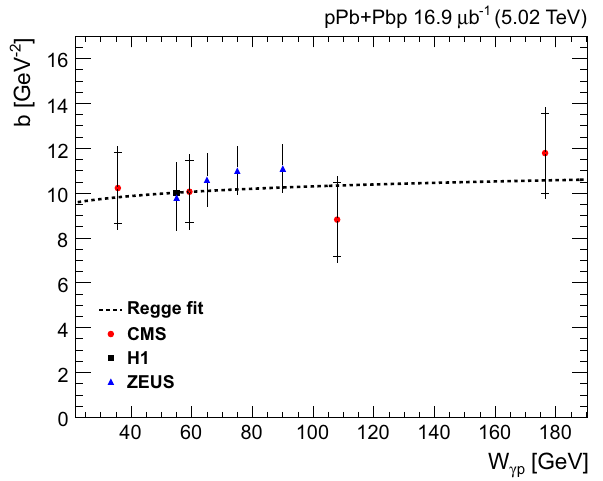
Fig. 6 Differential cross section d σ/ d | t | (full circles) for exclusive ρ ( 770 ) 0 photoproduction in the rapidity interval − 1 . 2 < y 0. The square symbols indicate the H1 results, and the triangles the ZEUS results. The error bars show the statistical uncertainty, while the shaded areas represent the statistical and systematic uncertainties added inquadrature.FortheH1data[18],theerrorbarsrepresentthestatistical andsystematicuncertaintiesaddedinquadrature,andfortheZEUSdata [17] the reported uncertainties are negligible Table 3 Differential cross section for exclusive ρ ( 770 ) 0 photoproduction, σ( γ p → ρ ( 770 ) 0 p ) , with statistical and systematic uncertainties, for | t | < 0 . 5 GeV 2 . The differential cross section d σ/ d | t | is also shown, along with the rapidity range, the average value of W